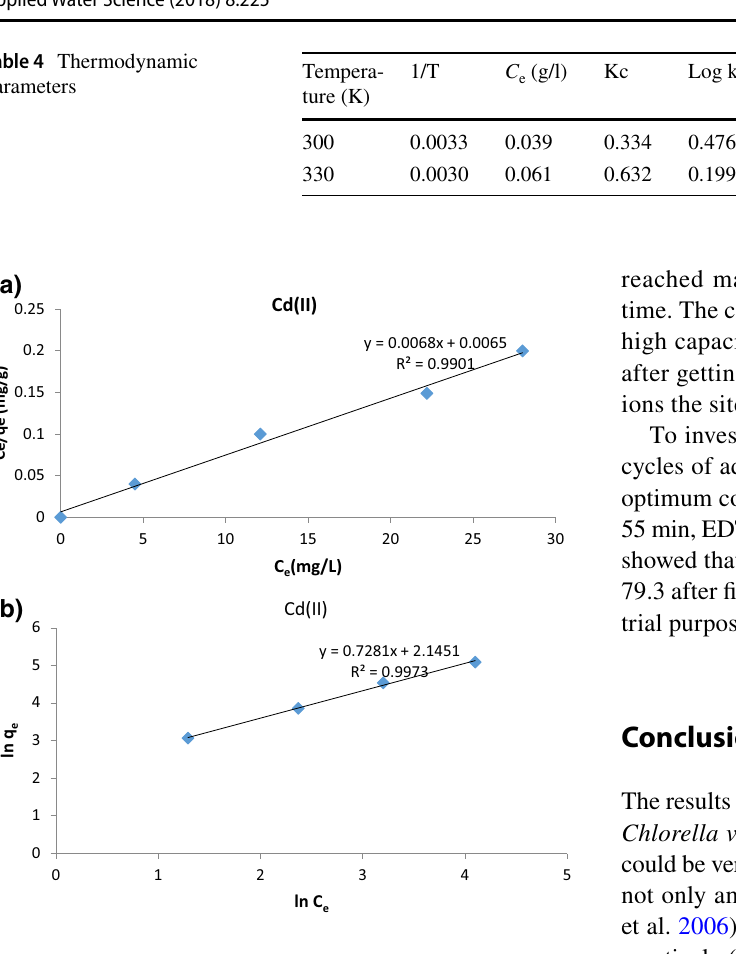
Fig. 7 a Langmuir isotherm plot for adsorption of Cd (II) on algal biomass of Chlorella vulgaris : pH = 4.5, Ci = 25–100 mg/L, dose = 1 g/L, time = unit hour at room temperature. b Freundlich iso- therm plot for adsorption of Cd (II) on algal biomass of Chlorella vulgaris : pH = 4.5, Ci = 25–100 mg/L, dose = 1 g/L, time = unit hour